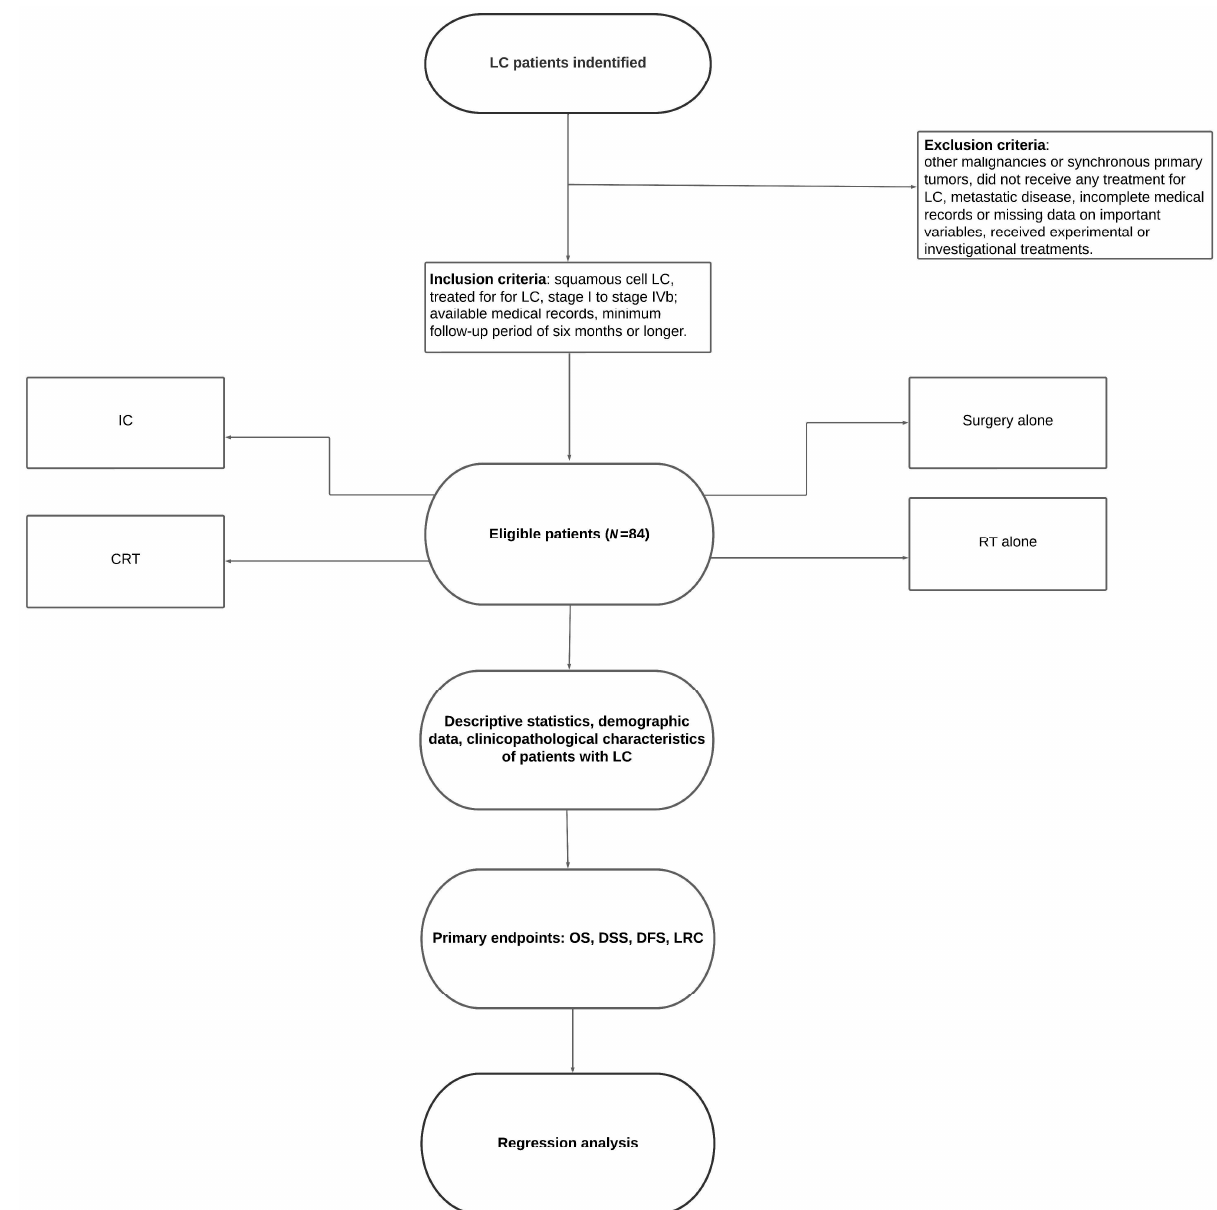
Figure 1. Flowchart of patient selection.